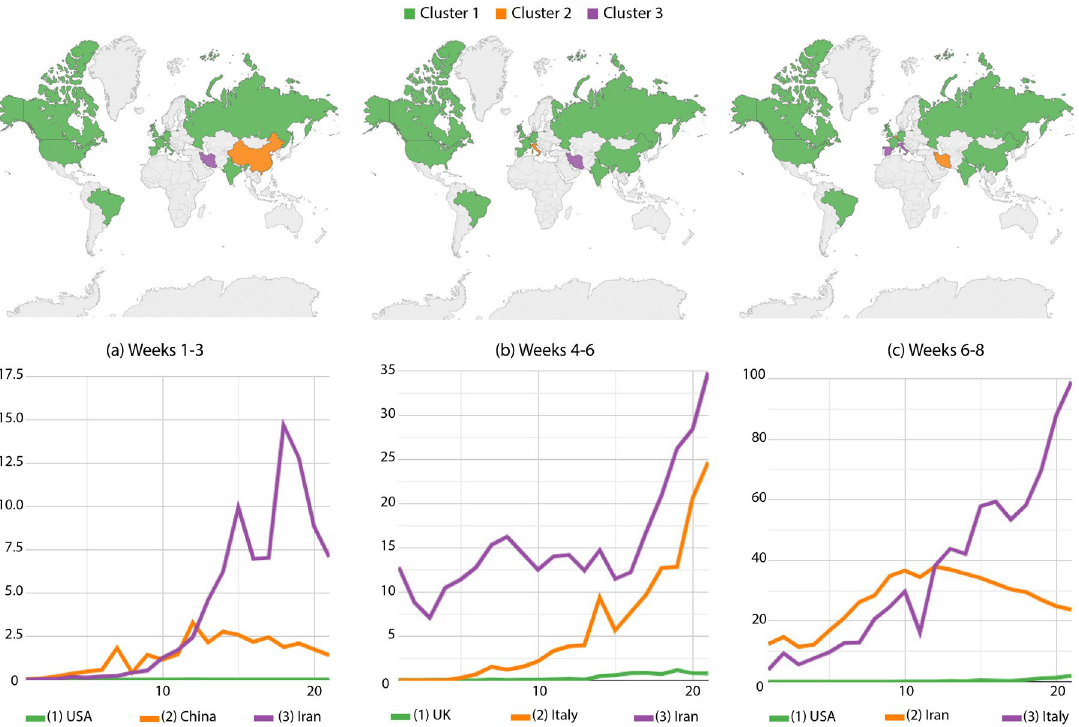
Figure 2. Confirmed cases per million inhabitants: country partitions along weeks 1–8. Top images identify country groups and bottom curves correspond to the infection incidence levels: green, orange and purple correspondingly map the low, medium and high-incidence groups. Curve legends indicate the group descriptor. Top-most maps were generated by using Tableau Desktop-Professional Edition (https:// www. table au. com/, version 20181.20.0213.2110-64 bit), and bottom-most charts were generated by using Google Charts (https:// devel opers. google. com/ chart, version